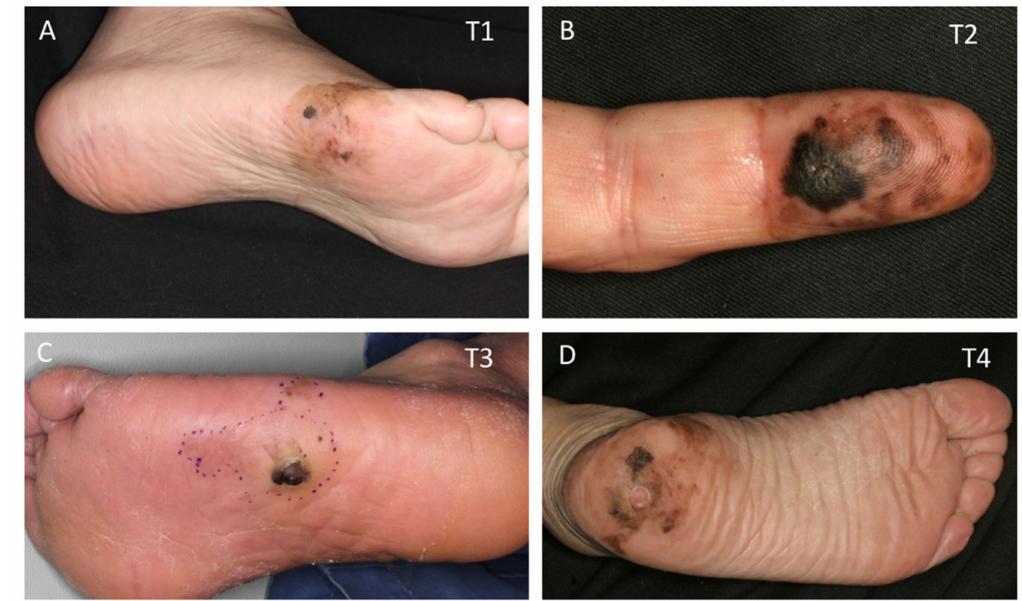
Figure 1. Acral melanoma: T1 ( A ), T2 ( B ), T3 ( C ), and T4 ( D ). All show a characteristic lentiginous spread of melanoma cells (acral lentiginous melanoma) with brown, irregularly shaped, wide-spreading